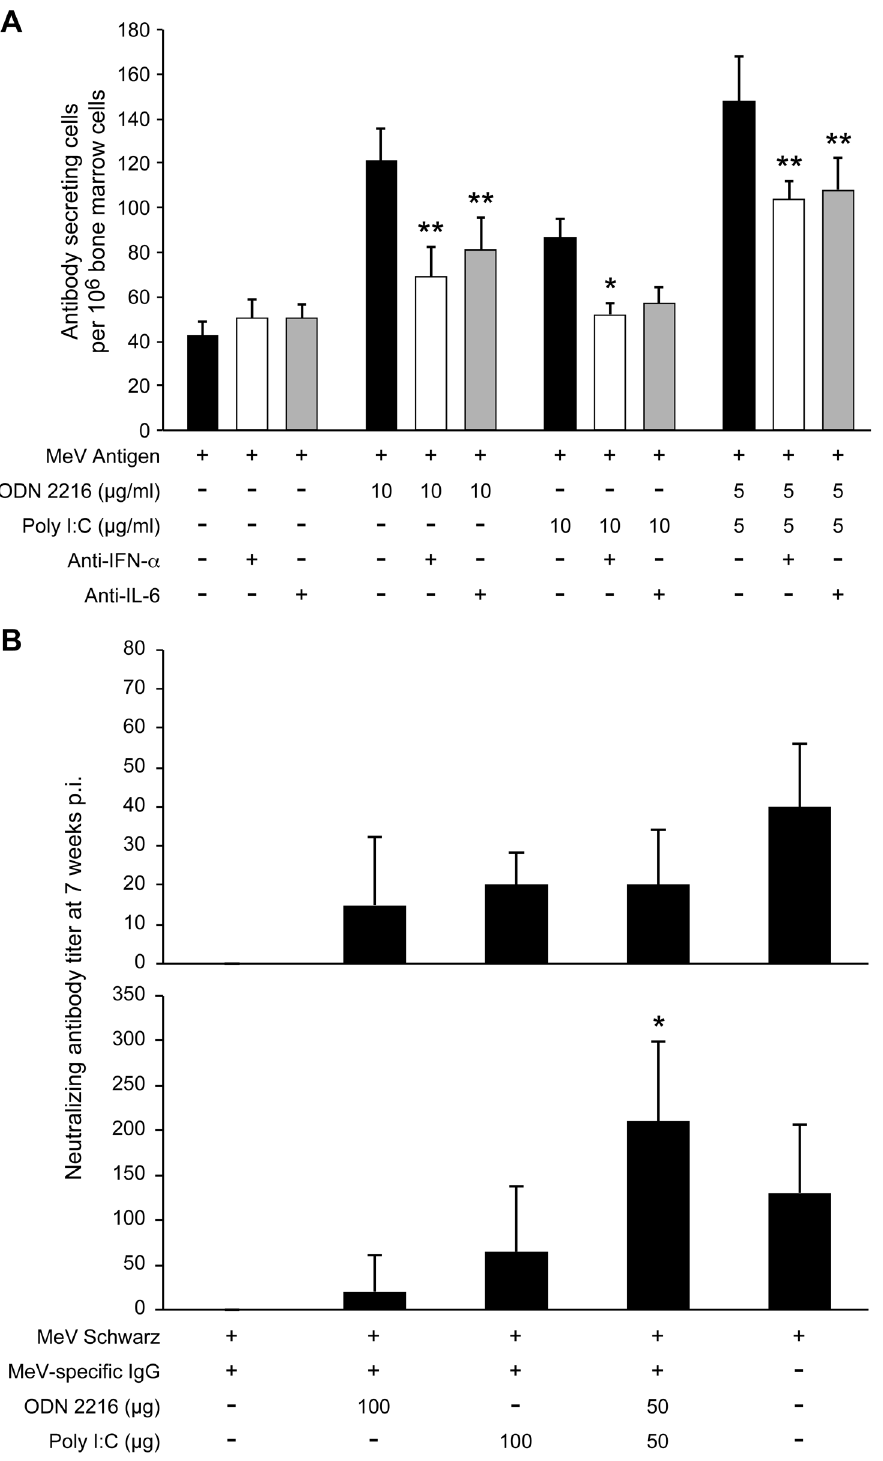
Figure 3. ODN 2216 and poly I:C stimulate B cell activation in vitro and restore the neutralizing antibody response after immunization in the presence of MeV-specific IgG. A) The number of MeV-specific B cells was measured from bone marrow cells of MeV- immune cotton rats. The addition of ODN 2216 and poly I:C individually and in combination increased B cell numbers whereas the addition of sera neutralizing cotton rat interferon alpha and IL-6 reduced this stimulation. Each bar graph represents the mean 6 SD of triplicate wells. B) Cotton rats were immunized intranasally (upper panel) or subcutaneously (lower panel) with MeV, or MeV with ODN 2216 and/or pI:C in the presence or absence of human MeV-specific IgG (neutralization titer of 100) which had been injected intraperitoneally one day before immunization. Sera were collected at seven weeks post vaccination and the titer of neutralizing antibody was determined by neutralization assay. Each bar graph represents the average titer of four animals 6 SD. The experiment is representative of three experiments. Statistical analysis was done by ANOVA (* p , 0.05, ** p , 0.01, *** p , 0.001). doi:10.1371/journal.ppat.1003233.g003 PLOS Pathogens |